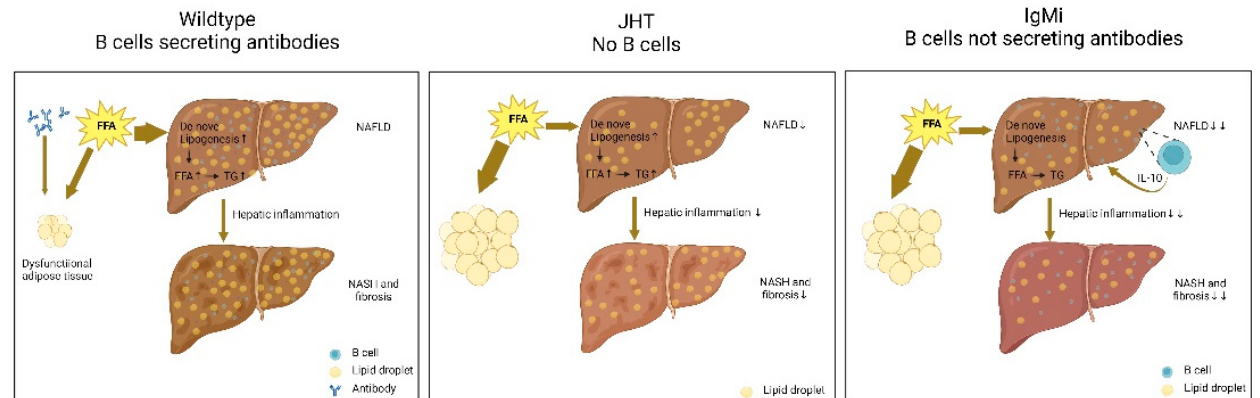
Figure 1. B cells have both detrimental and protective effects in diet-induced NAFLD. The HFD feeding of wild-type mice resulted in manifest NAFLD that was characterized by macrovesicular steatosis associated with massively increased liver weight and a proinflammatory intrahepatic immune response. Both restricted B cell function (IgMi) and complete lack of B cells (JHT) are protected from high-fat diet-induced inflammation and hepatic steatosis. The common feature of JHT and IgMi mice is that they do not secrete antibodies. The pathogenic antibodies secreted by B cells play a significant role in the enhancement of NAFLD pathology by inducing adipose tissue dysfunction. Remarkably, the mice completely lacking B cells (JHT) were partially protected whereas B-cell-harboring but antibody-deficient IgMi mice were completely protected from the development of hepatic steatosis, inflammation, and fibrosis. This is due to the IL-10–producing regulatory B cells providing protection